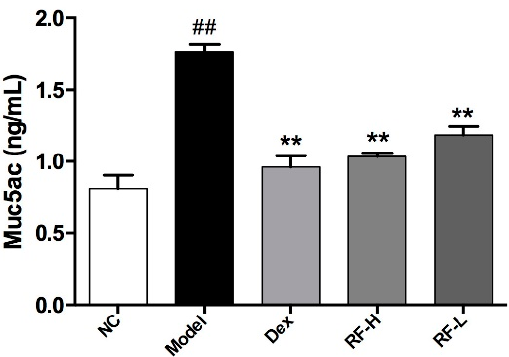
Figure 5. The effects of Renifolin F on Muc5ac levels in BALF. Normal control, saline-induced mice only. Model, OVA-induced mice. Dex, OVA-induced mice treated with Dex (1.0 mg/kg). RF-H, OVA-induced mice treated with Renifolin F (3.0 mg/kg). RF-L, OVA-induced mice treated with